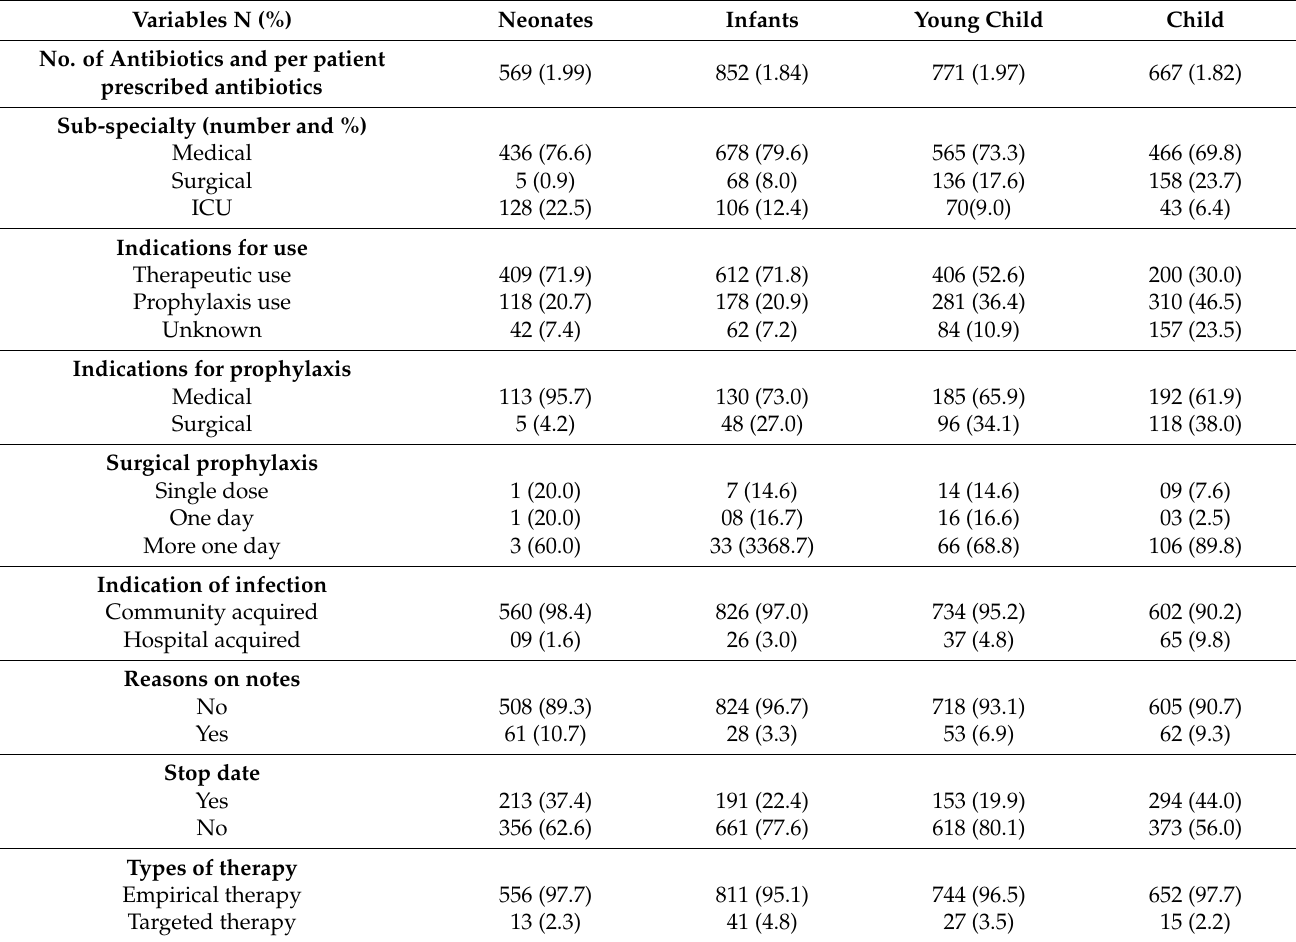
Table 2. Details of prescribed antibiotics according to age groups.